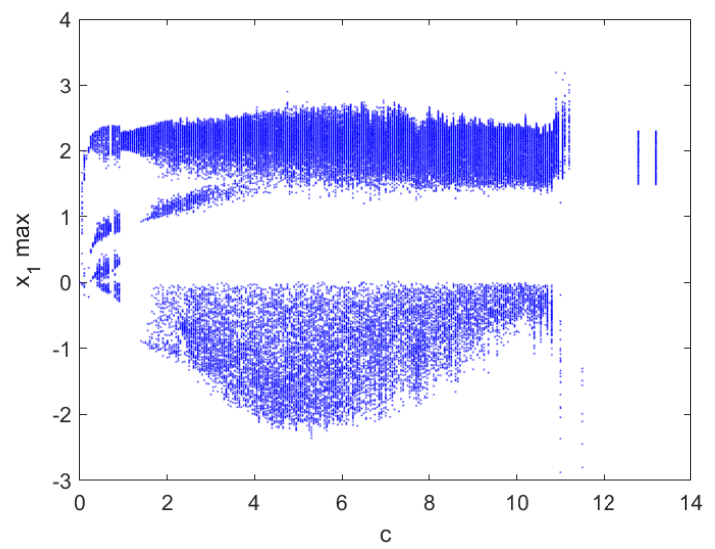
Figure 17. Bifurcation diagram for c ∈ [ 0,14 ]